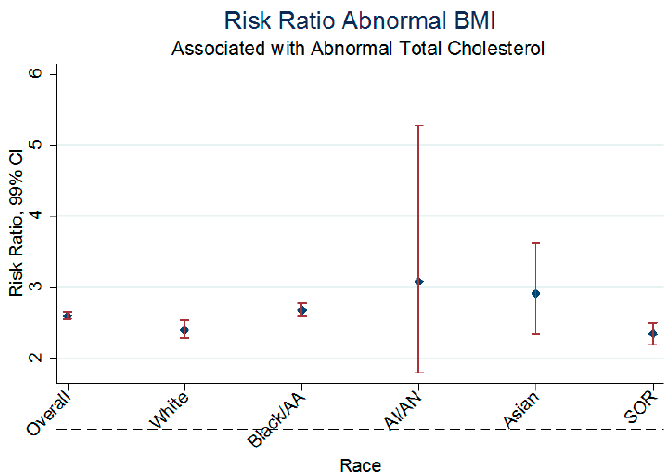
Figure 2. The overall and adjusted RR on the association between BMI and Total Cholesterol Other